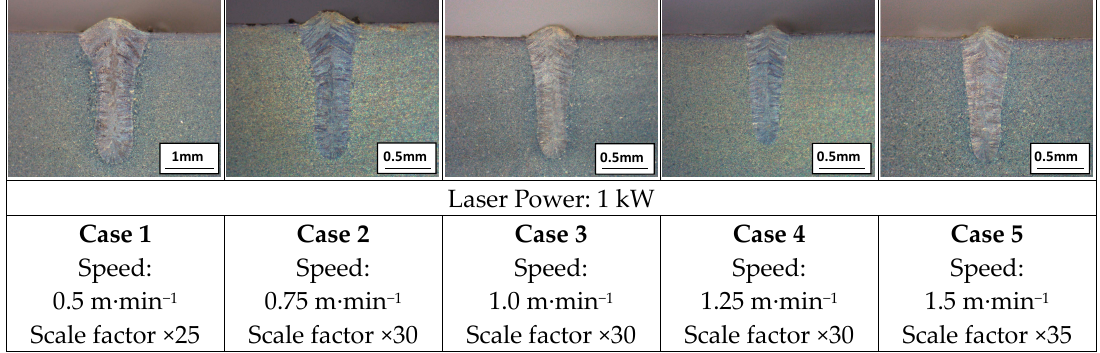
Figure 3. Bead geometry on BOP welding test (laser power: 1 kW, Case 1~5).